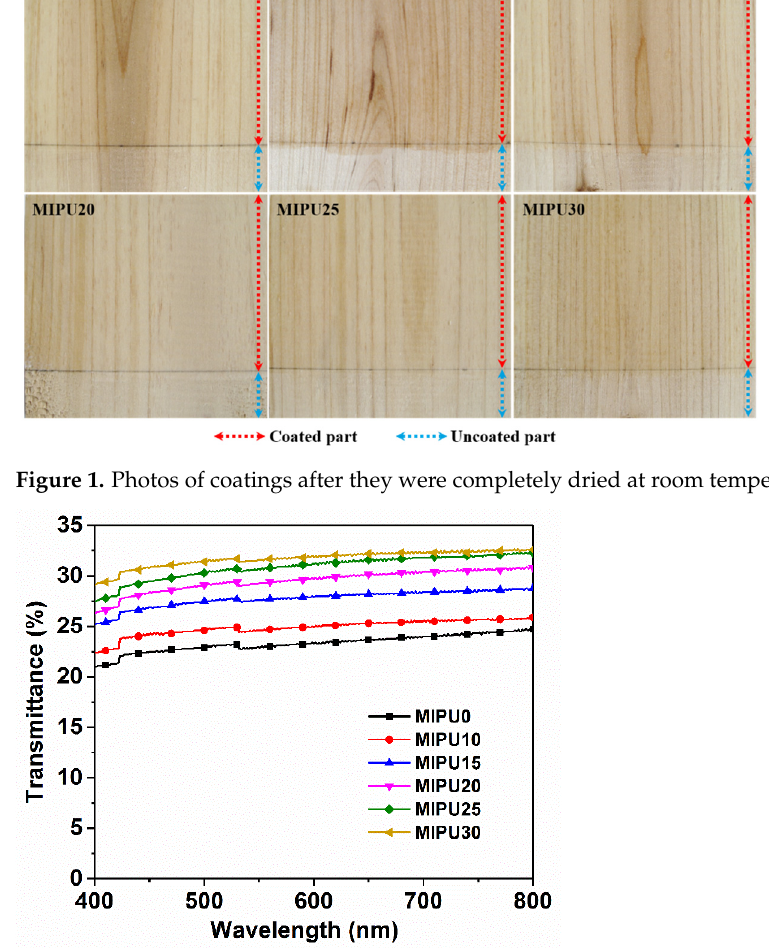
Figure 2. Transmittance of the